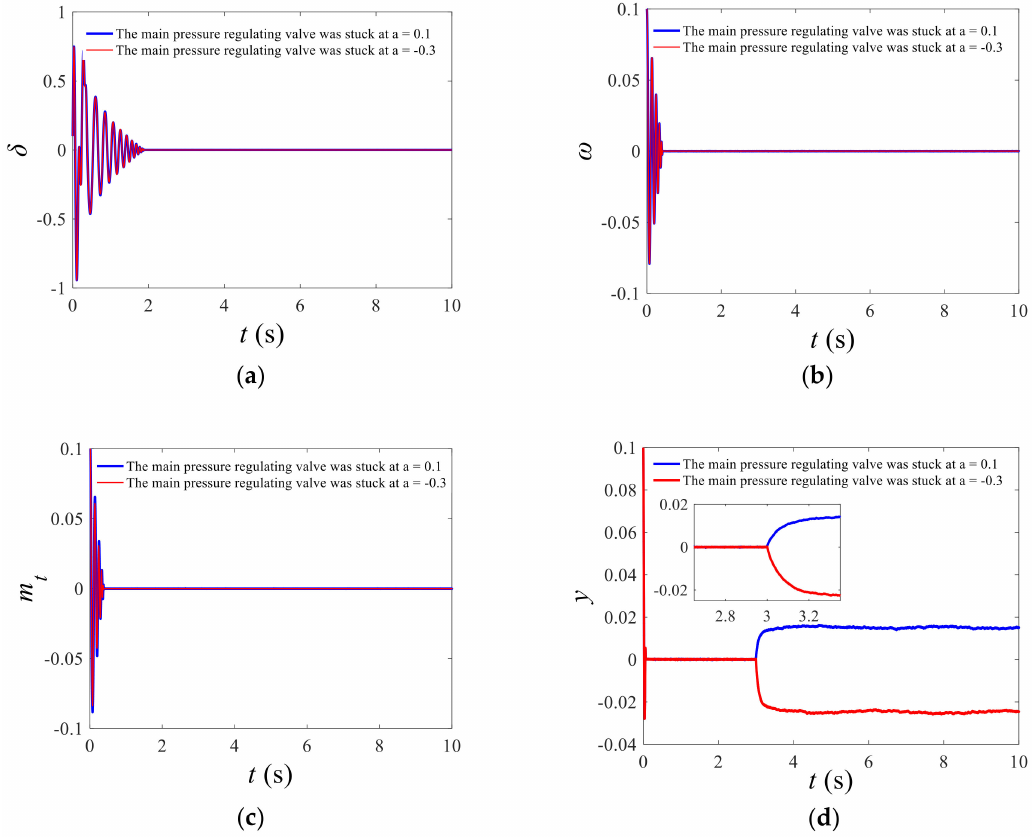
Figure 3. State trajectories of the HTGS under an actuator lock-in-place fault. ( a ) δ ( t ) − t ; ( b ) ω ( t ) − t ; ( c ) m t ( t ) − t ; ( d ) y ( t ) − t